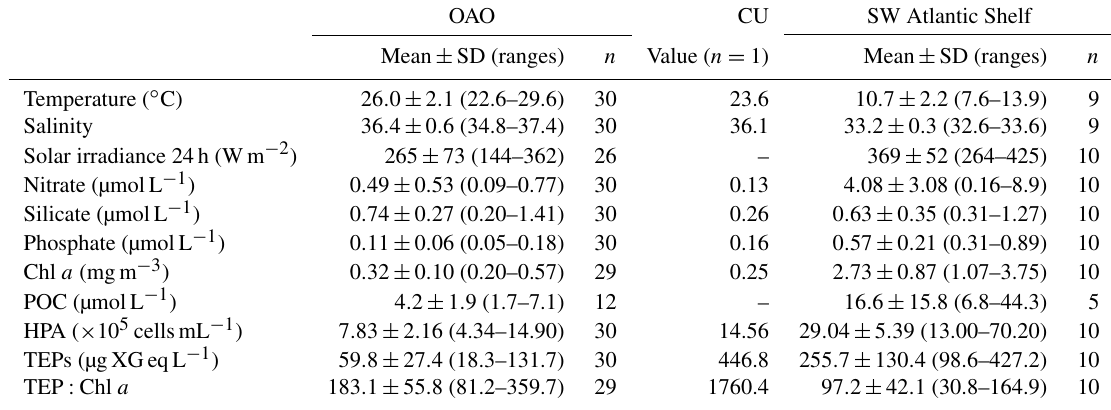
biomass (Table 3) and with some phytoplankton biomass groups: Synechococcus ( R 2 = 0 . 30), picoeukaryotes ( R 2